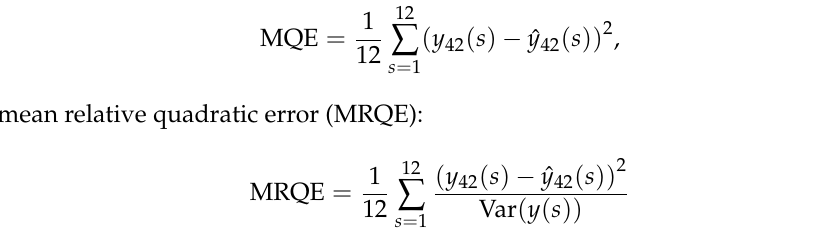
are used to evaluate the prediction ability of the model, where Var ( y ( s )) is the empirical variance of { y i ( s ) } 41 . Table 5 shows the MQE and MRQE of LAD, HB, EXP and OLS i = 1 estimation. It can be seen from Table 5 that the robust estimation procedure performs better than OLS when there are some